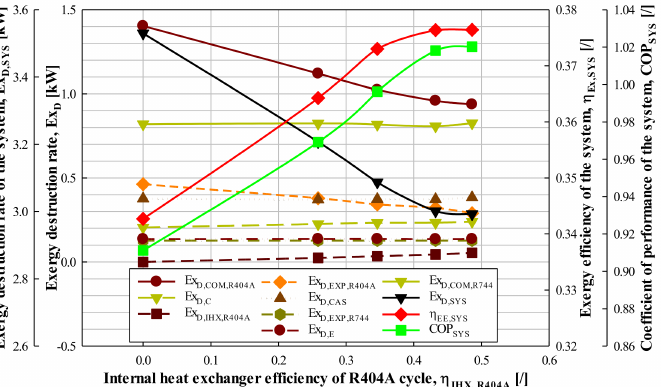
Figure 10. Exergy destruction rate, exergy efficiency and COP of the CRS with respect to the IHE efficiency of the R404A